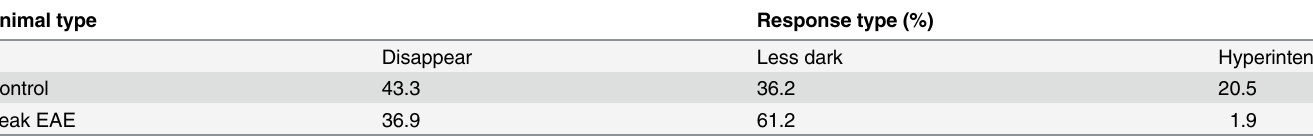
Table 1. Proportion of response types to 100% O 2 for all animals